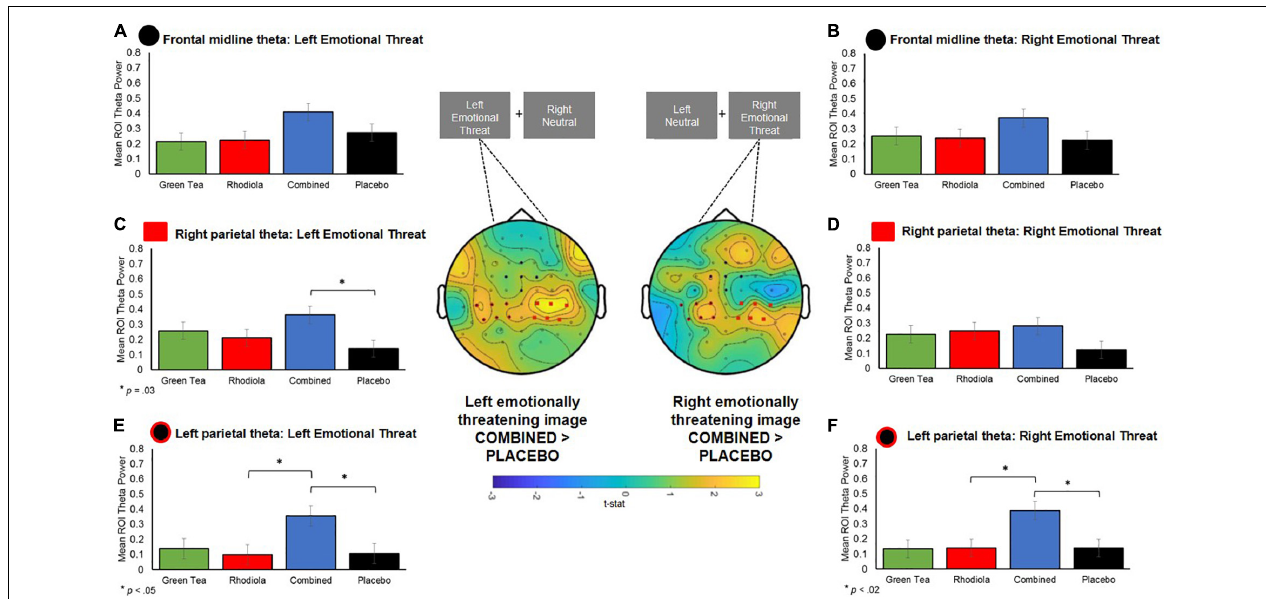
FIGURE 8 | Central figure: T-statistic maps of spectral theta activity difference between COMBINED and PLACEBO treatments 0.5–0.75 s after presentation of the images, distinguished by left and right emotionally threatening image presentation. Positive values in maps indicate COMBINED > PLACEBO. ROI electrodes symbols shown on maps and in respective summary bar chart. (A,B) Theta band activity in a priori defined ROI midline frontal region for left and right presented images. (C,D) RIGHT parietal a priori defined ROI theta activity when emotionally threatening image shown on left and right. (E,F) LEFT parietal a priori defined ROI theta activity when emotionally threatening image shown on left and